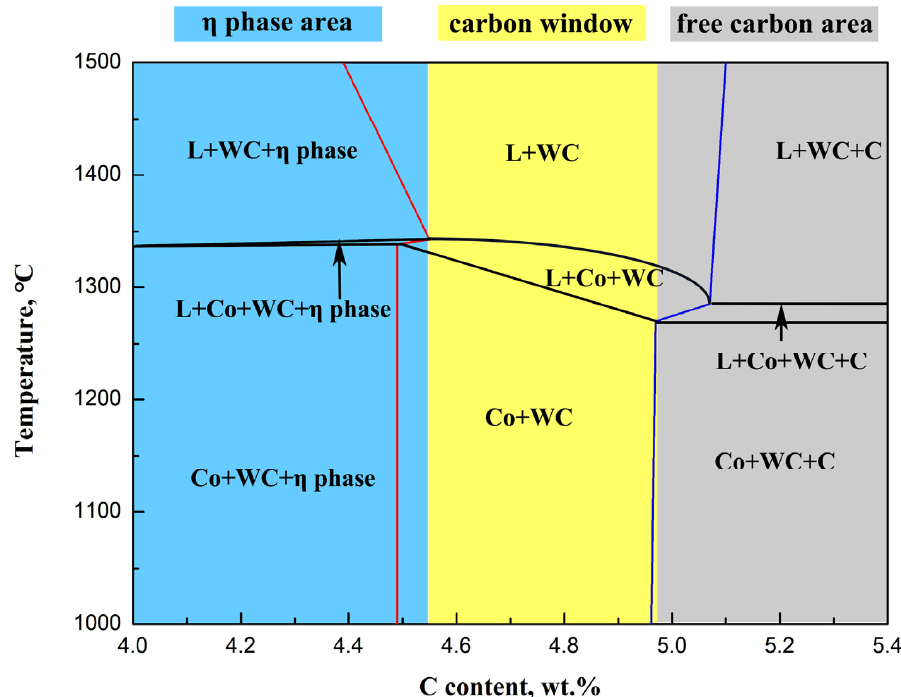
Figure 6. The vertical section of the phase diagram in the WC ‐ 20Co cemented carbide.